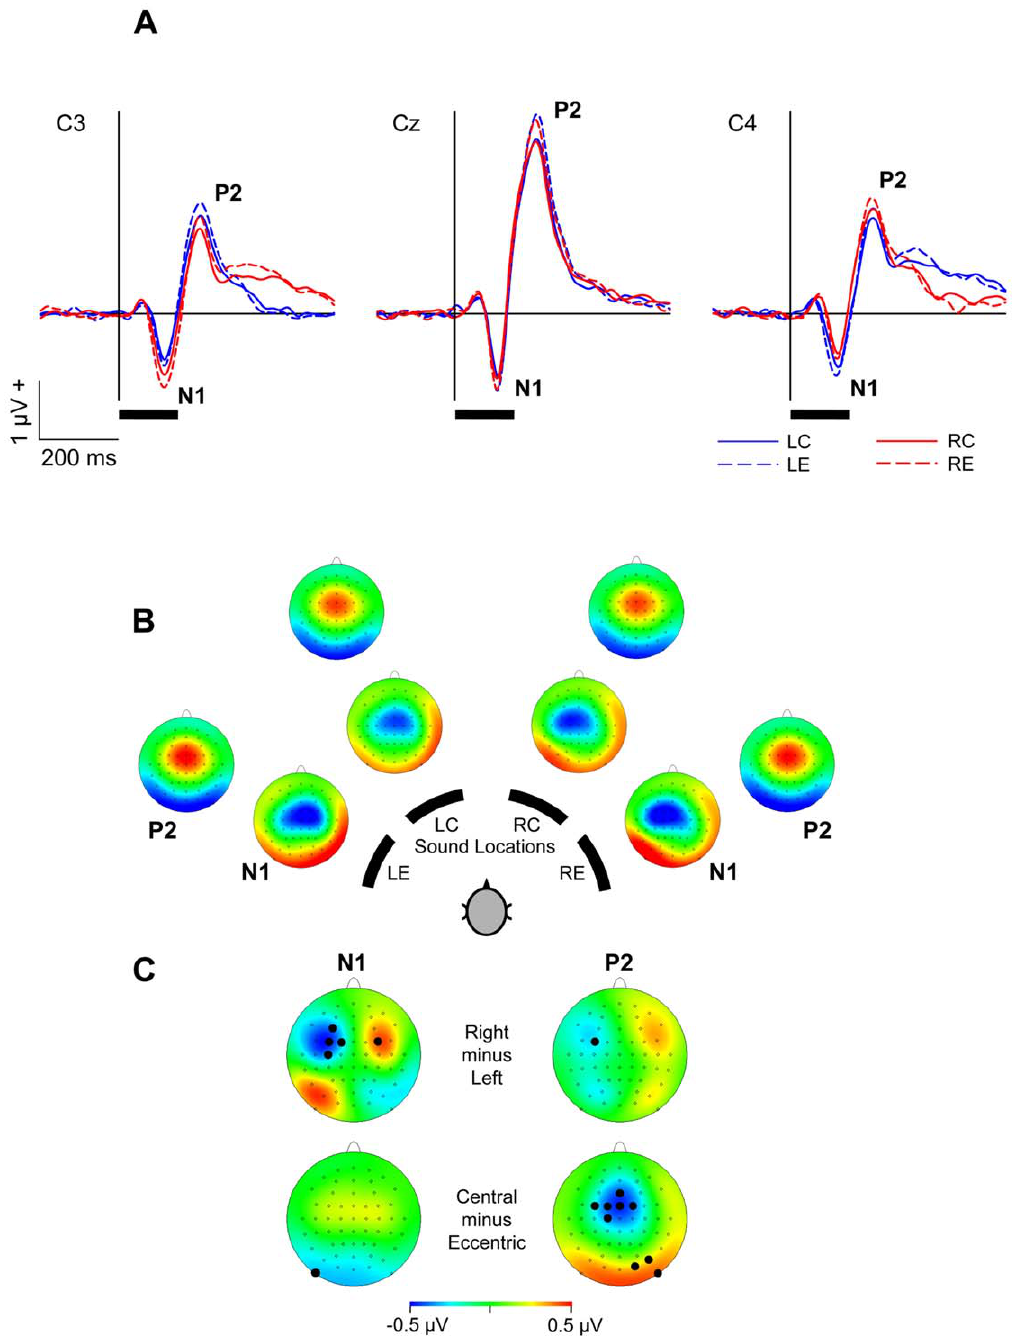
Figure 1. Auditory-evoked potentials. ( A ) Grand-average AEPs with N1 and P2 components at a left (C3), vertex (Cz), and right (C4) electrode position, plotted as a function of time relative to sound onset for left-eccentric (LE), left-central (LC), right-central (RC), and right-eccentric (RE) ranges of sound locations. Black horizontal bars indicate stimulus duration. ( B ) Topographies for the four ranges of sound locations (LE, LC, RE, RC) at the time of N1 and P2. ( C ) Difference topographies of N1 and P2, comparing right and left sound positions, and central and eccentric sound positions. Filled circles indicate electrodes with significant differences in amplitude values (significant t -values according to permutation tests, all p , 0.05).